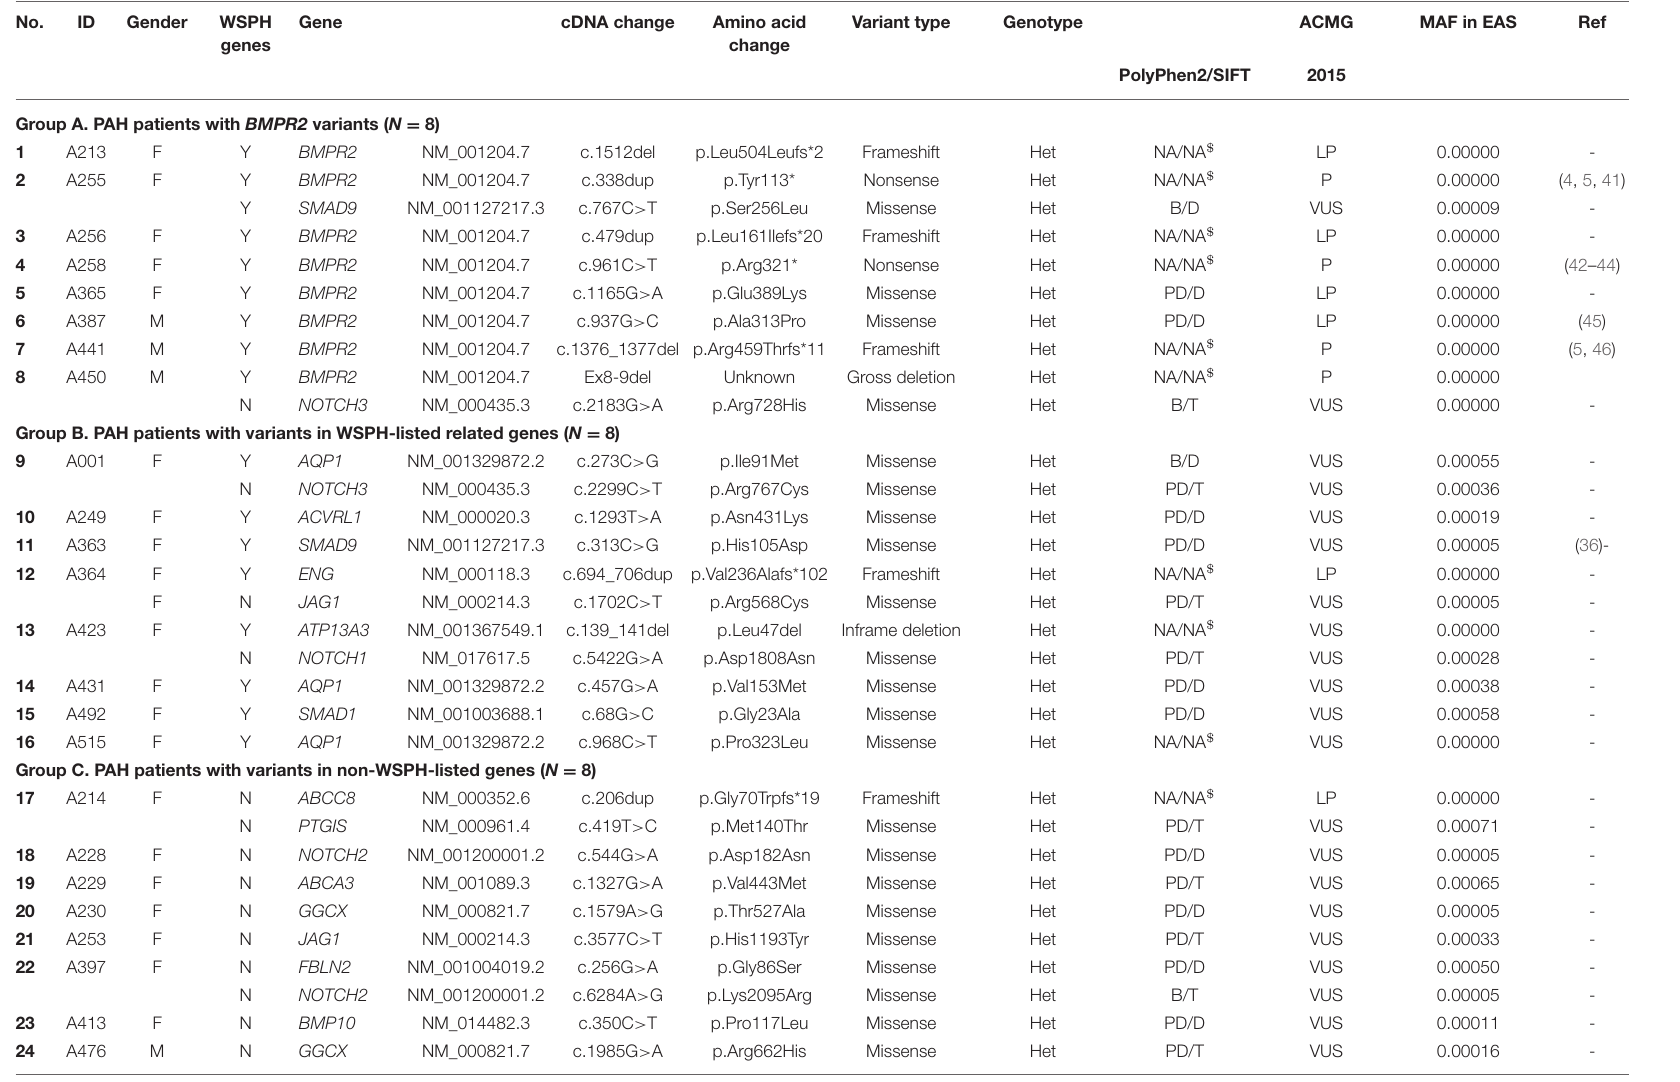
TABLE 1 | Details of genetic variants in PAH-related